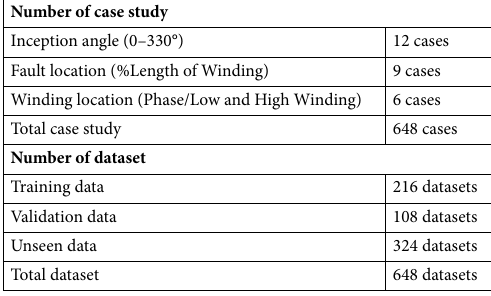
Table 3. Number of case study and data set.